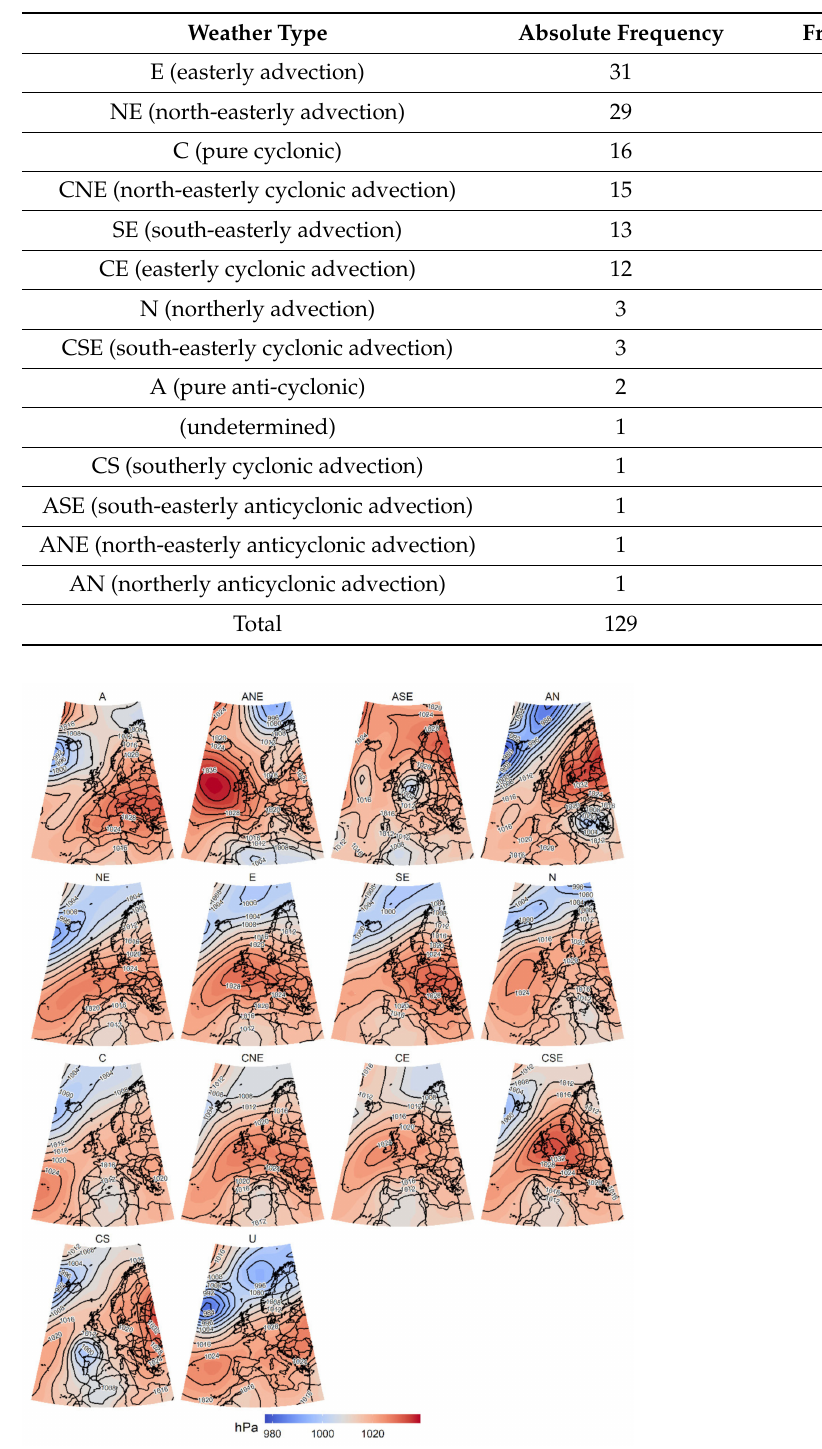
Table 4. Atmospheric situations causing intense rainfall events analysed in the study according to